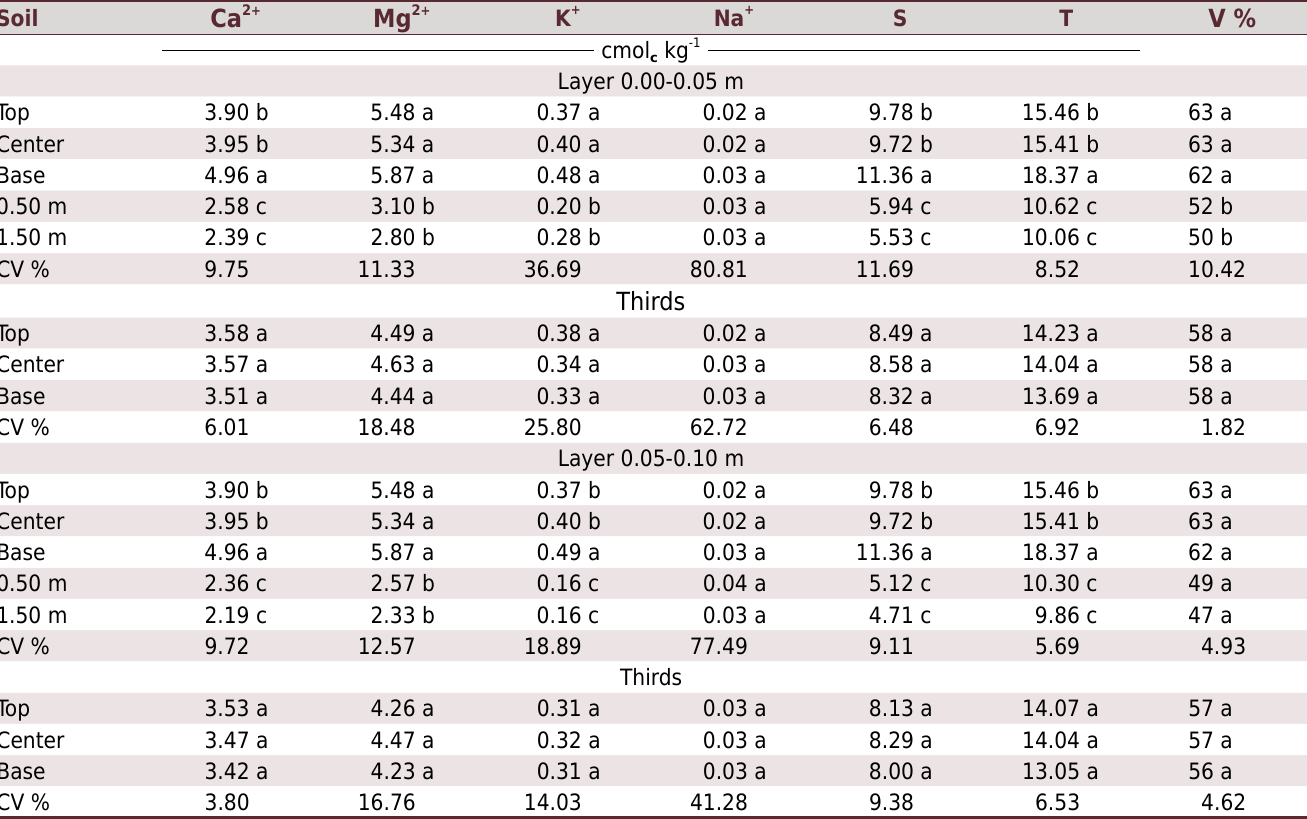
Table 4. Chemical properties of termite mounds and the surrounding soil in the 0.00-0.05 and 0.05-0.10 m layers, Mar de Morros region, municipality of Pinheiral, Rio de Janeiro